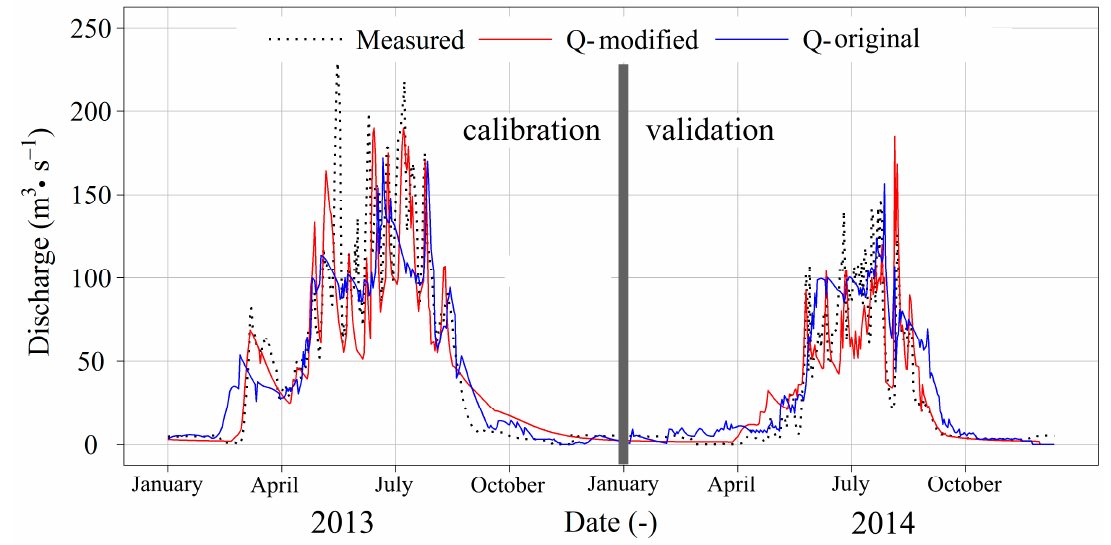
Figure 5. Comparison of simulated with measured streamflow processes during the calibration and validation periods (2013–2014). validation periods (2013–2014). Water 2018 , x, x